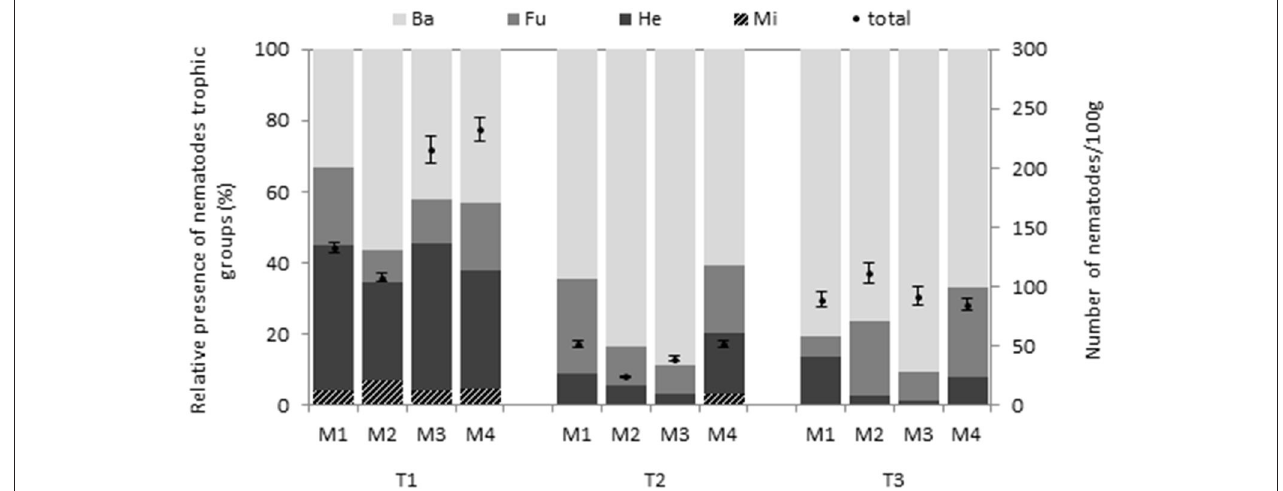
FIGURE 2 | Bar chart represents the relative presence of the different nematode trophic groups identified in the soil samples: bacterivores (Ba), fungivores (Fu) and herbivores (He). The pathogen nematode M. incognita (Mi) was also included to discriminate it from herbivores. The total number of nematodes in 100g of soil (dry matter) is represented by dot chart with the standard errors. Values were obtained for the four biodisinfestation treatments (M1, M2, M3, M4) at three different times: T1 (pre-treatment), T2 (post-treatment) and T3 (post-crop after treatment).